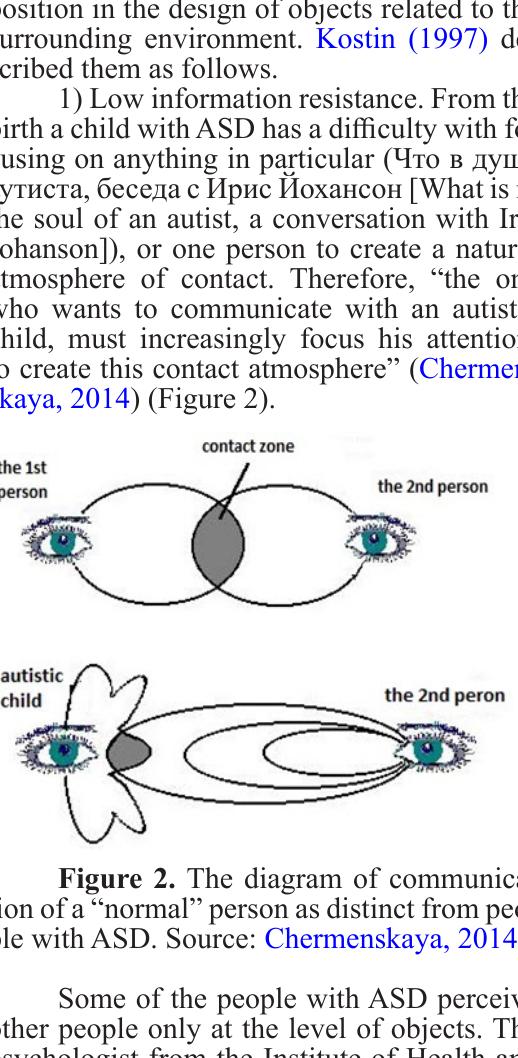
brain of these children is excessively